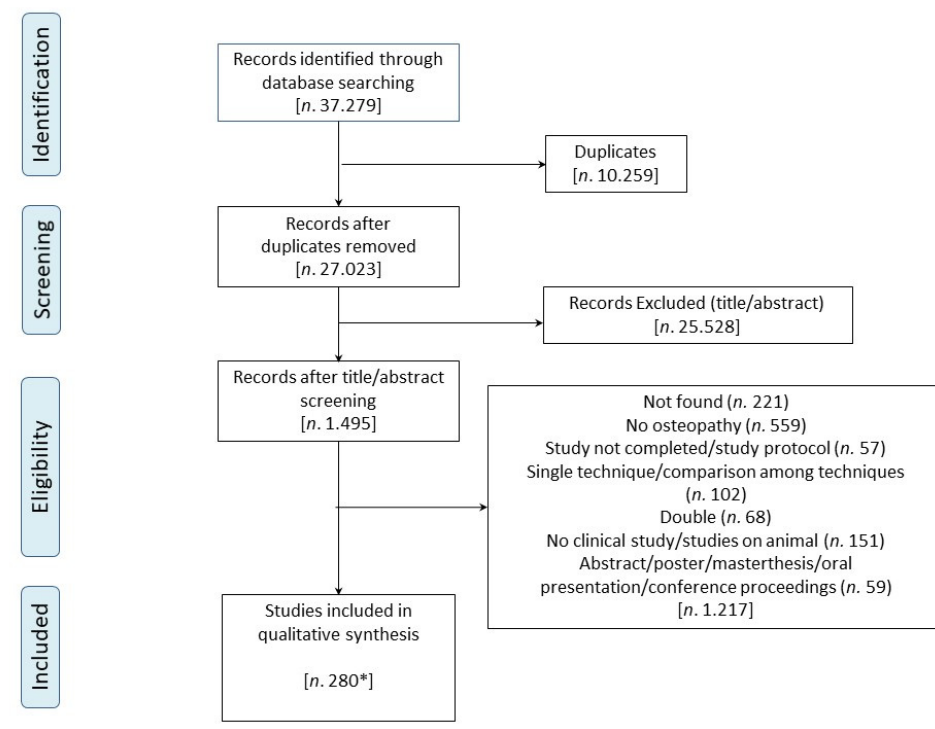
Figure 1. PRISMA flow diagram. * Two articles were considered doubled.